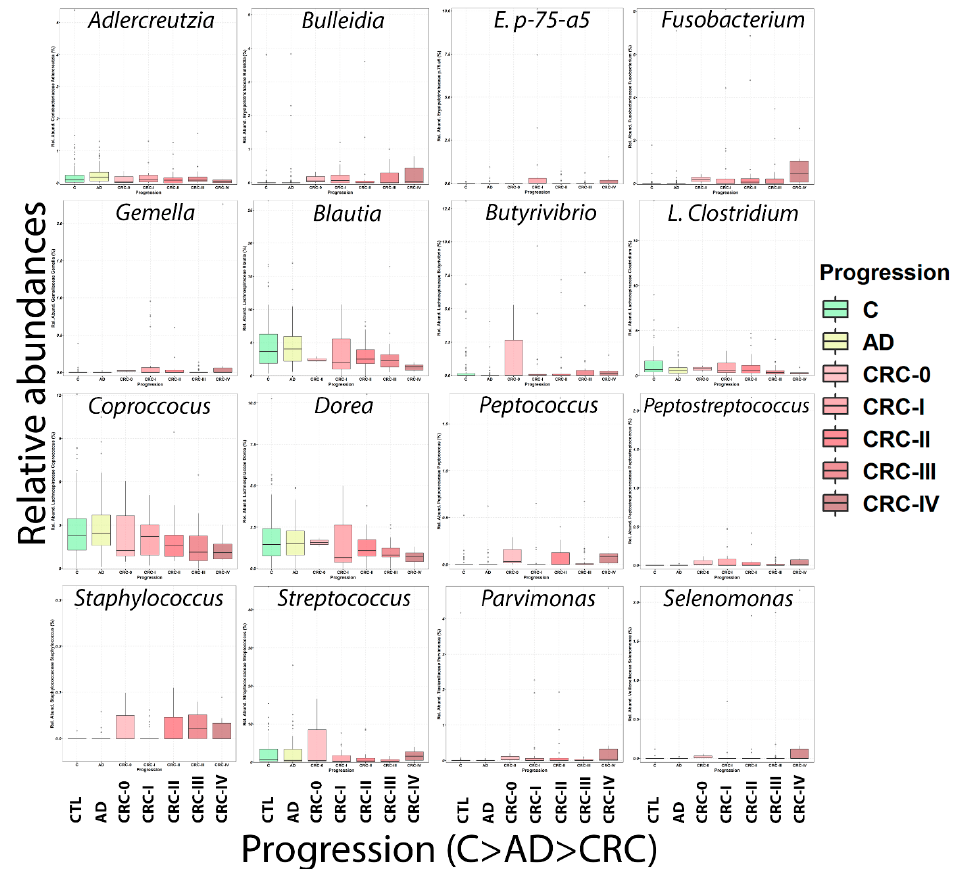
Figure 5. Relative abundance per sample group and CRC stage group of the 16 differentially abundant genera (n C = 74, n AD = 62, n CRC ‐ 0 = 3, n CRC ‐ I = 22, n CRC ‐ II = 22, n CRC ‐ III = 30 and n CRC ‐ IV =